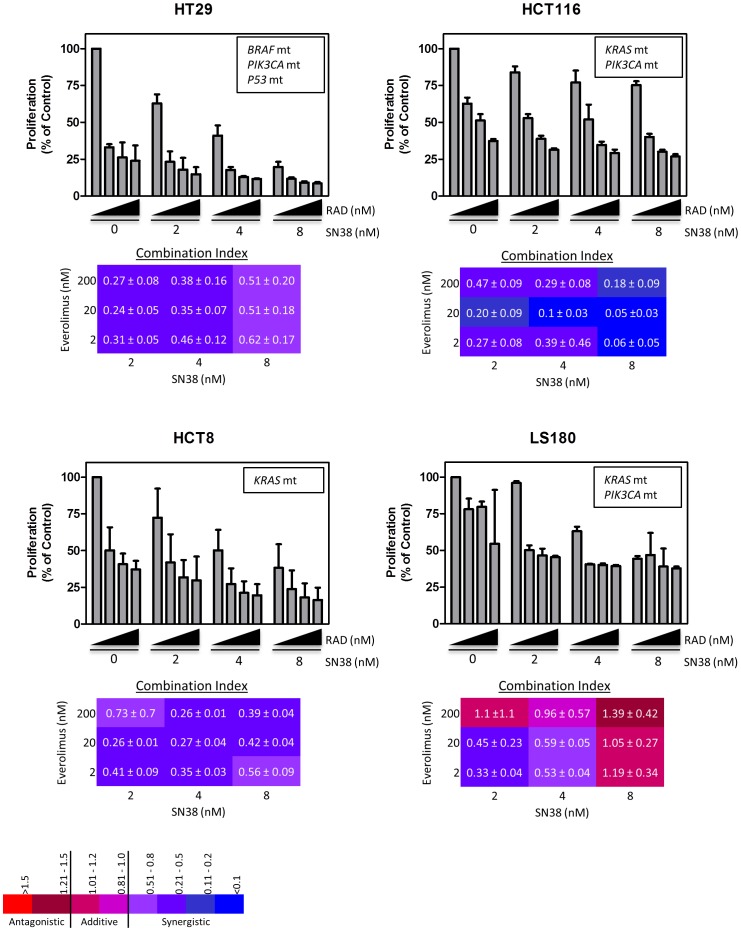

In vitro anti-proliferative effects of everolimus (RAD) and SN38 combinations in colorectal cancer cell lines.The combinatorial anti-proliferative effects were evaluated in HT29, HCT116, HCT8 and LS180 cells to assess potential additive or synergistic interactions. Growth inhibition was measured by the sulforhodmine B assay (SRB) following a 72 hour incubation with SN38 (0, 2, 4 or 8 nM) and RAD (0, 2, 20 or 200 nM - indicated by the triangels under the graphs). Data on the graphs represents the mean ± standard deviation of at least 3 separate experiments. The combination index (CI) values were calculated for for all combinations and the values ± the standard deviation are presented in the colored tables below each graph.. The %CV for replicates ranged from 5–40% and averaged ∼20% therefore, we determined that CI values>1.2 are considered antagonistic, 1.2> CI>0.8 are additive, and CI<0.8 are synergistic. Note that SN38 is used in in vitro assays instead of irinotecan since it is the active metabolite.